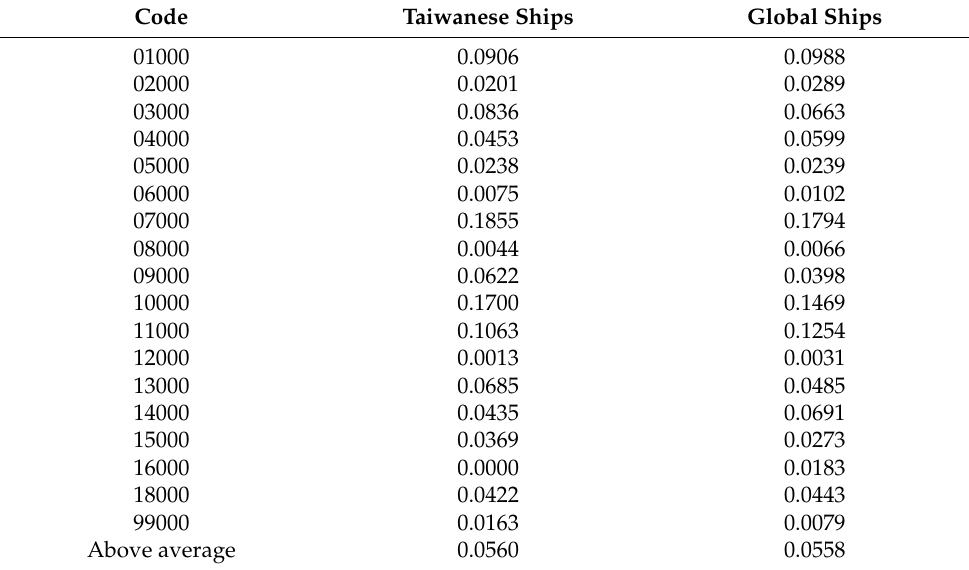
Table 7. Statistics on the fuzzified deficiency categories of ships in Taiwan and ships in the world in the Tokyo MoU from 2014 to